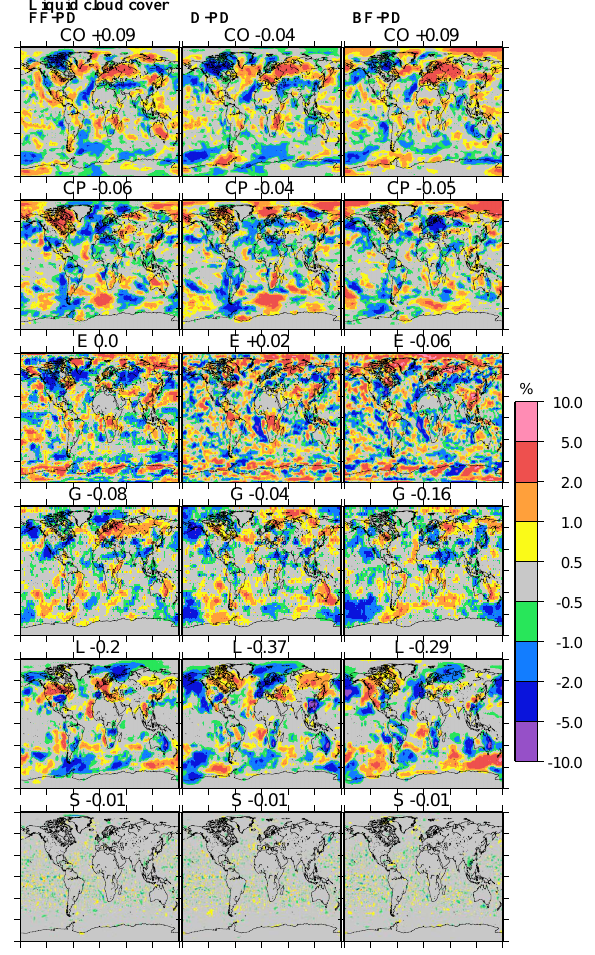
Fig. 5. Difference in annual cloud cover from the fossil fuel (left), diesel (middle) and biofuel (right) reduction experiments and the full simulation. All results are for liquid cloud cover except E which is low cloud cover. Each row is one